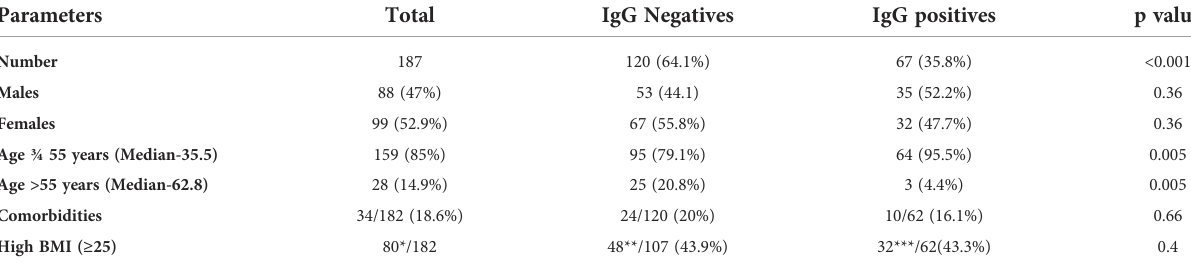
TABLE 1 Demographic characteristics of the COVISHIELD recipients analyzed post-2 nd dose.